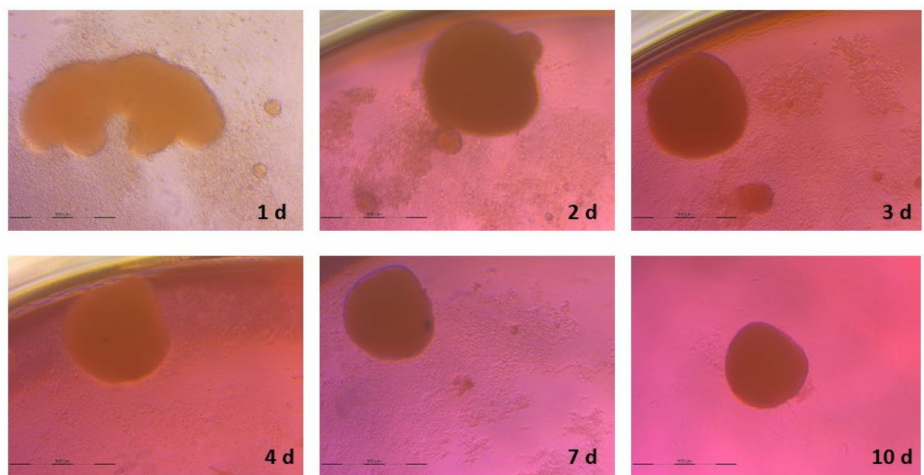
Figure 2. Timeline images of spheroid formation from 1 day to 10 days of culture in basal conditions.